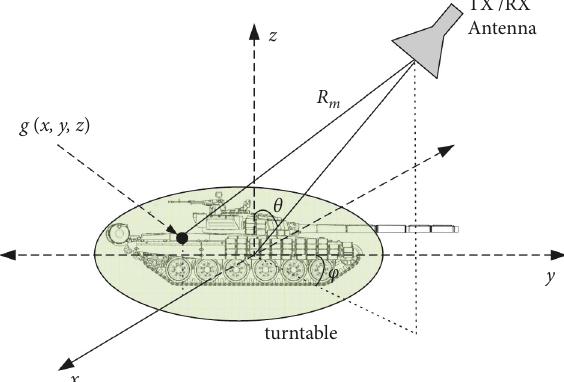
Figure 1: 2D monostatic turntable ISAR imaging